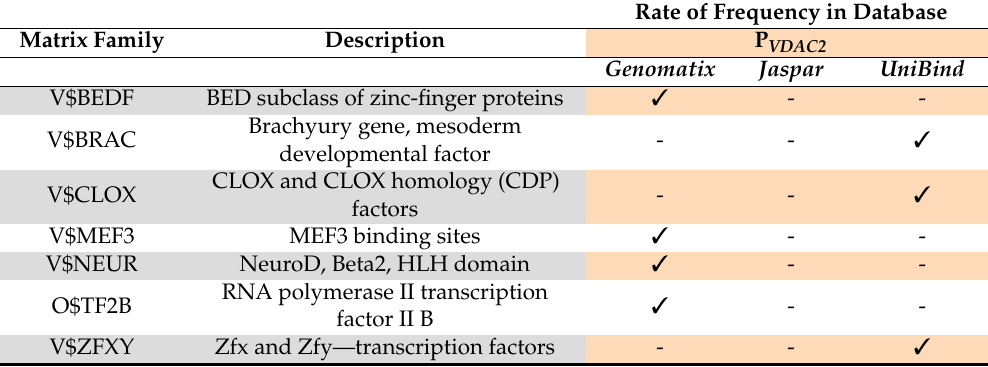
Table 3. VDAC2 unique Transcription Factor Binding Sites (TFBSs). The sign (cid:51) indicates the presence of the TFBS in P VDAC2 sequence selected by a specific database.